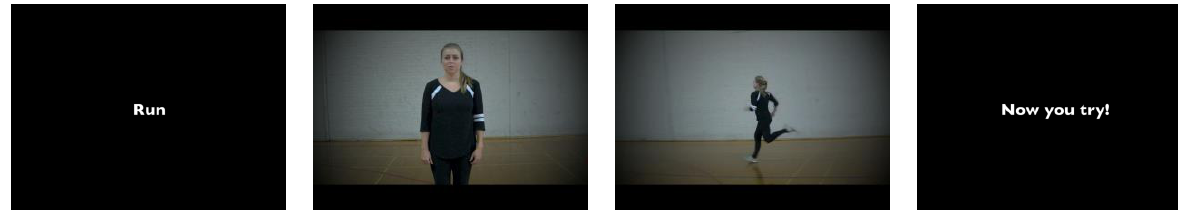
Figure 1— Example photo stills of a typical video shown to participants before specified TGMD-3